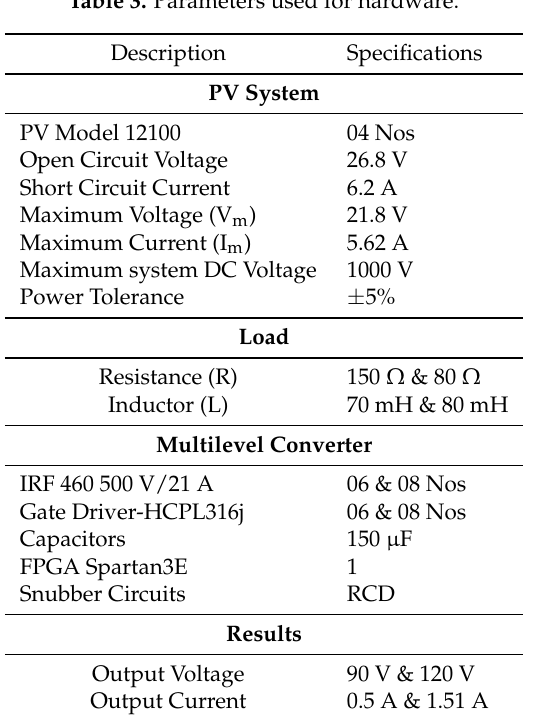
Figure 8. Simulation of PV module. Table 3. Parameters used for hardware.